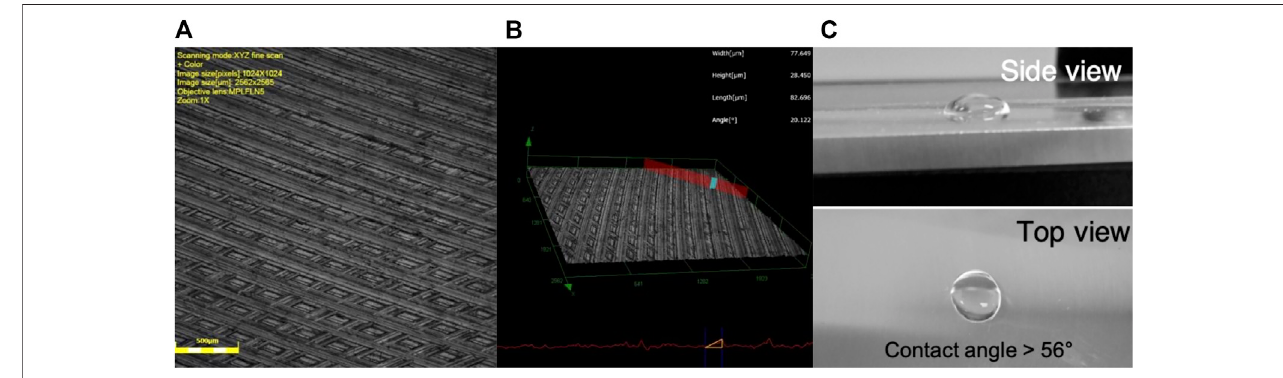
FIGURE 1 | Aluminum substrate prior surface treatment. (A) Confocal Laser microscope image. Pattern of groves and marks atop the aluminum samples. (B) 3D image and topographic pro fi le of the aluminum samples. (C) Picture of the surface of the AA 2024T351 before abrasion